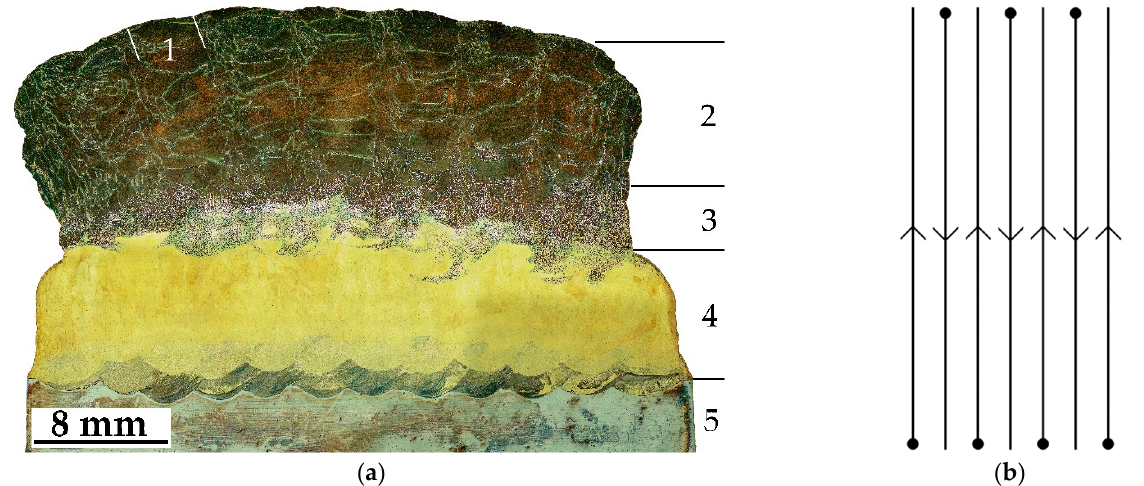
Figure 2. ( a ) Optical image of the bulk sample cross-section: (1) single track pool; (2) Cu–Al–Mn stable layers; (3) transition zone; (4) Cu–Al layers; (5) steel substrate. ( b ) Scheme of the printing strategy.